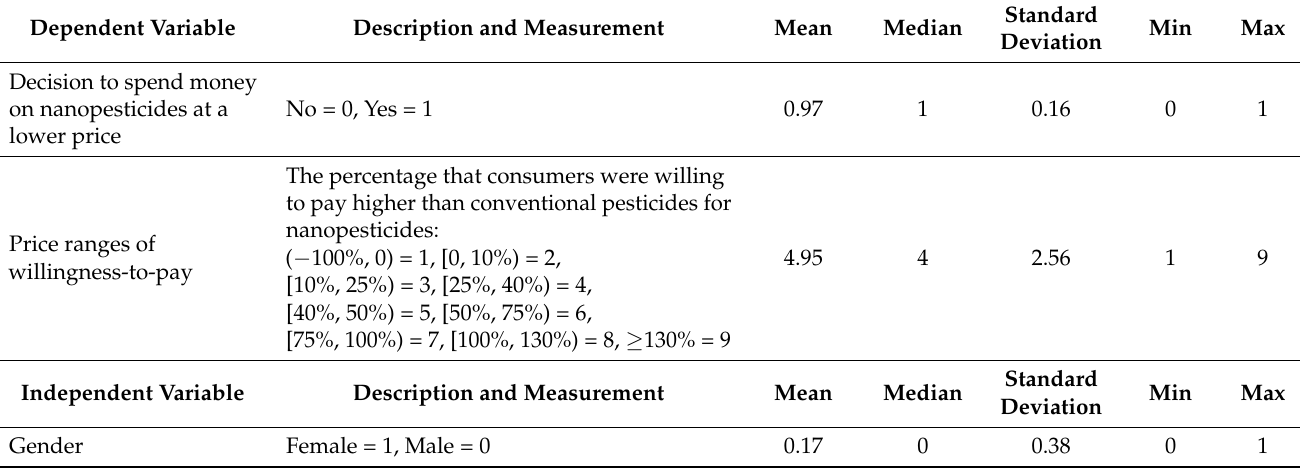
Table 1. Overview and measurements of the variables and descriptive statistics of 232 pesticide